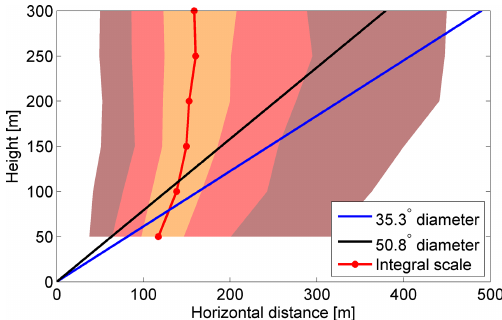
Figure 7. The diameter of the scanning circle of the two PPI scans is shown in comparison to l . The red line denotes the median l , while the progressively darker contours represent the 40–60, 25–75, and 10–90 percentile intervals of l over the entire 17-day experimental period.